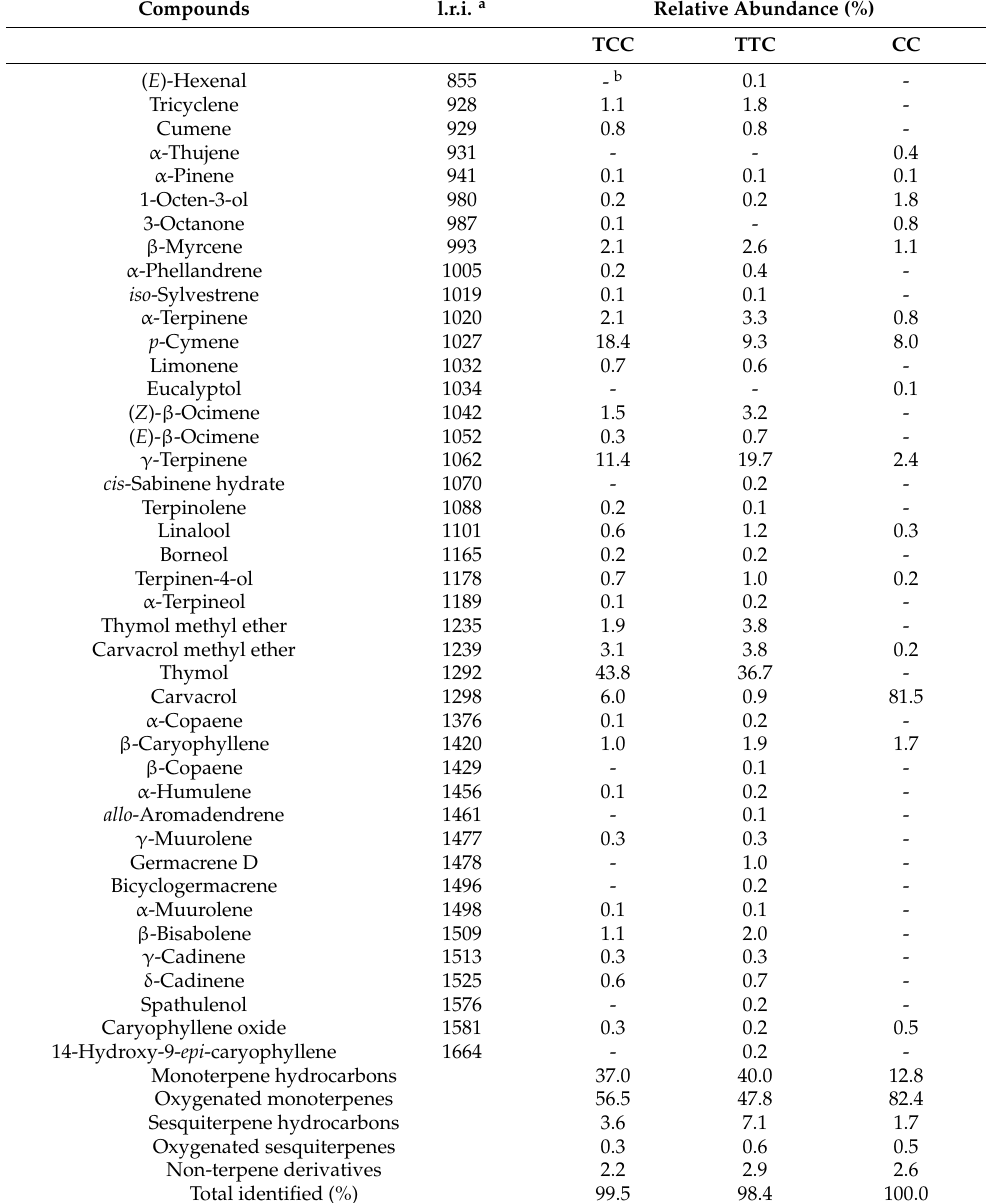
Table 1. Chemical compositions (compounds > 0.1%) of the essential oils hydrodistilled from the aerial parts of the three Origanum vulgare accessions.